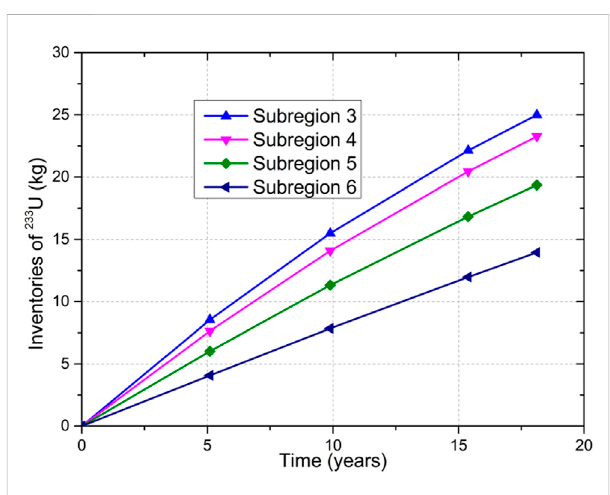
FIGURE 13 Time evolutions of 233 U inventories in the